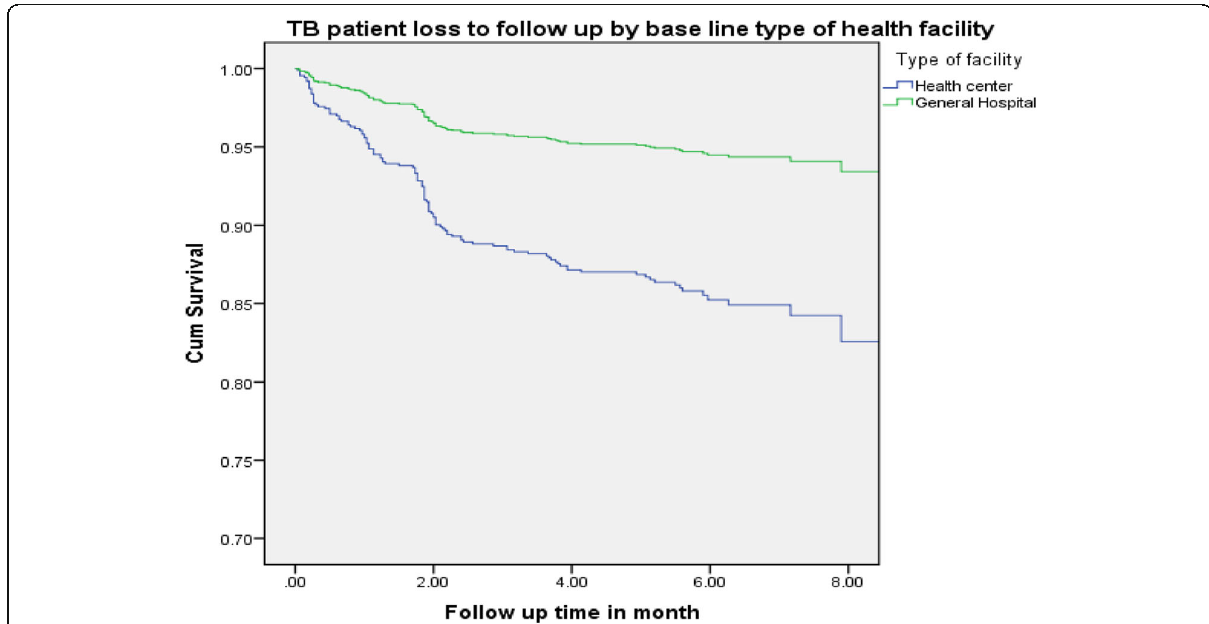
Fig. 3 Survival experiences of loss to follow-up TB patients separated by baseline type of health facility among tuberculosis patients registered to tuberculosis treatment and care at health facilities, rural Ethiopia, during 2008 –